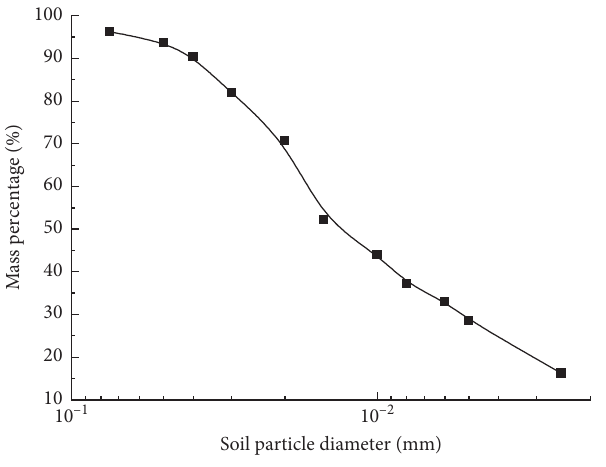
Figure 1: Grain size distribution Table 1: Physical properties of loess.